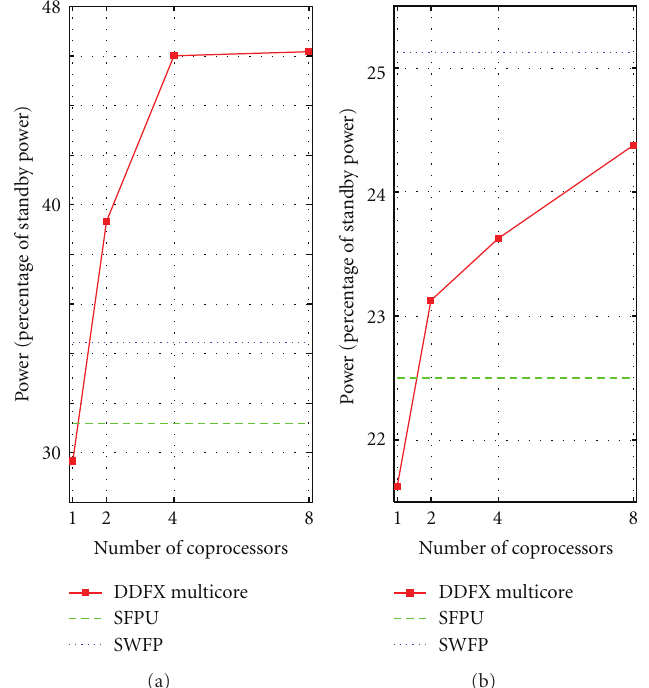
Figure 12: Dynamic power consumption for Virtex II Pro (a) and Virtex 4 (b). These measurements were taken using running hardware systems described in Section 5.